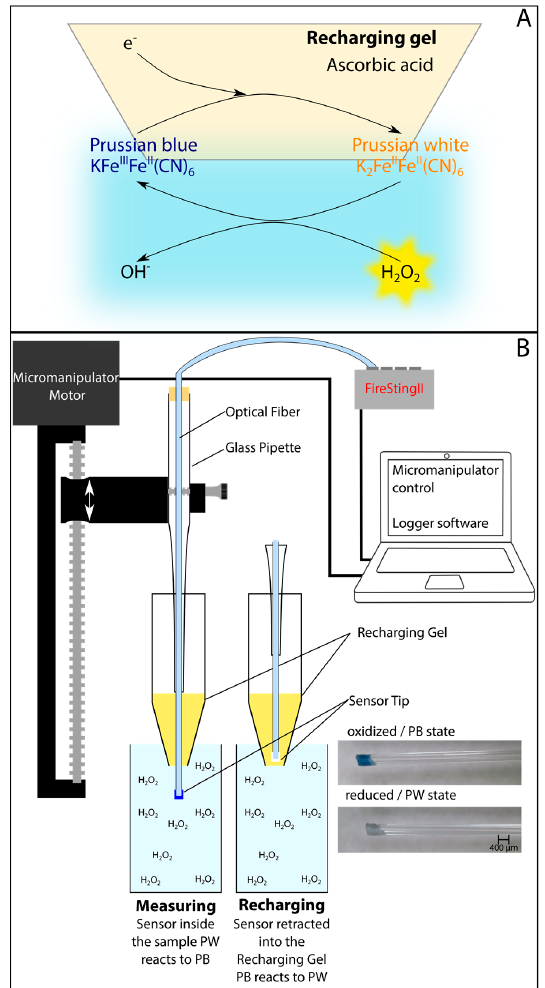
Figure 6. Principle for a fiber-optic H 2 O 2 detection system. ( A ) Shows the Prussian Blue (PB)/Prussian White (PW) redox scheme. PW is oxidized to PB by H 2 O 2 in the sample. It can then be regenerated externally by reducing it with e.g., ascorbic acid to PW; ( B ) PB coated on a fiber tip together with a luminescent crystal, allowing pseudo-continuous measurements with an optical fiber. The fiber can be retracted into the recharging gel to regenerate the tip in between measurements. Reproduced from [69]—Published by The Royal Society of Chemistry.